Question: Which visualization type does this figure use?
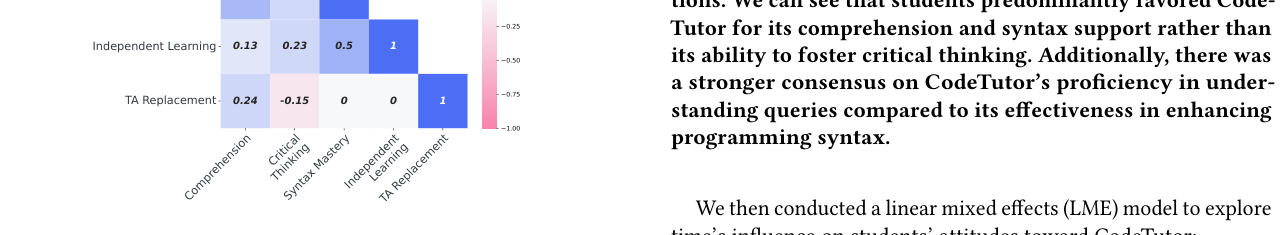
Answer: heatmap